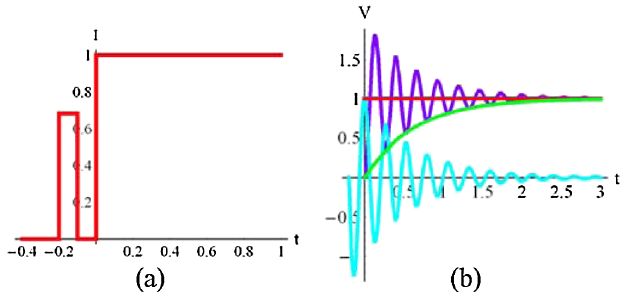
FIG. 12. (Color) Fore pulse method. (a) Current profile. (b) The reduced filling time by cancellation of the two beating transients. The cyan curve is the voltage induced by the first step pulse, the purple curve is induced by the second one, the red curve is the final voltage by summing two beating transients, and the green curve is the standard filling time curve for a single step pulse.